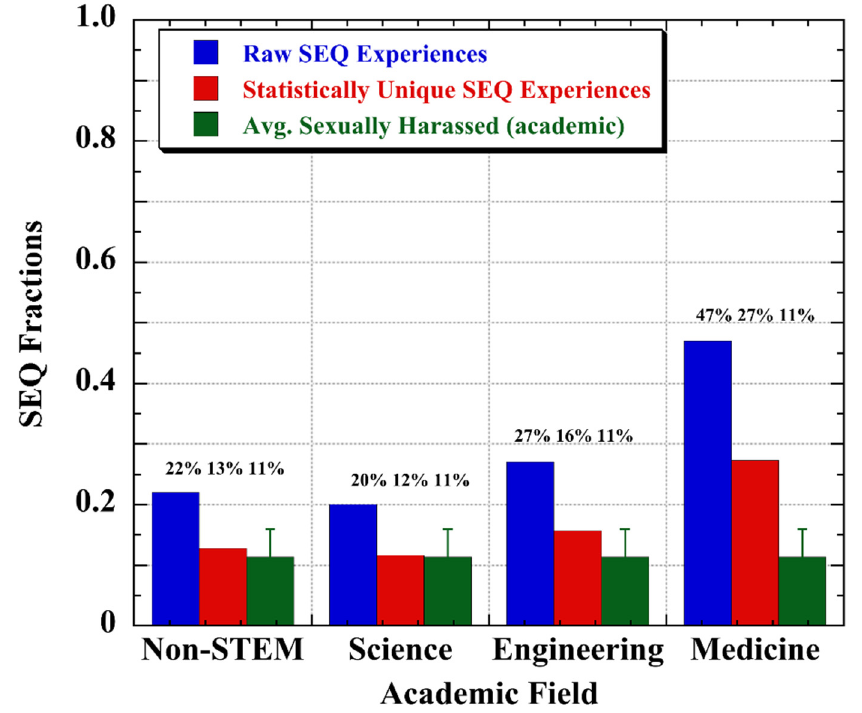
Figure 7. SEQ experiences of academic STEM females. Bars are: ( blue ), from Appendix D of the NAS Report, their Figure D-1; ( red ), the same Figure D-1 of the NAS Report after correction for 0.72 factor correlation; and; ( green ), average fraction of women reporting sexual harassment across all academic departments (not STEM alone), given by positive criterion answers from two different academic SEQ studies [22,31]. The whiskers on the green bars are ±0.047. The NAS authors count the blue SEQ experiences as sexual harassment, no matter whether the respondents did so or not. The red bars indicate statistically independent SEQ experience fractions, not the incidence of SH.